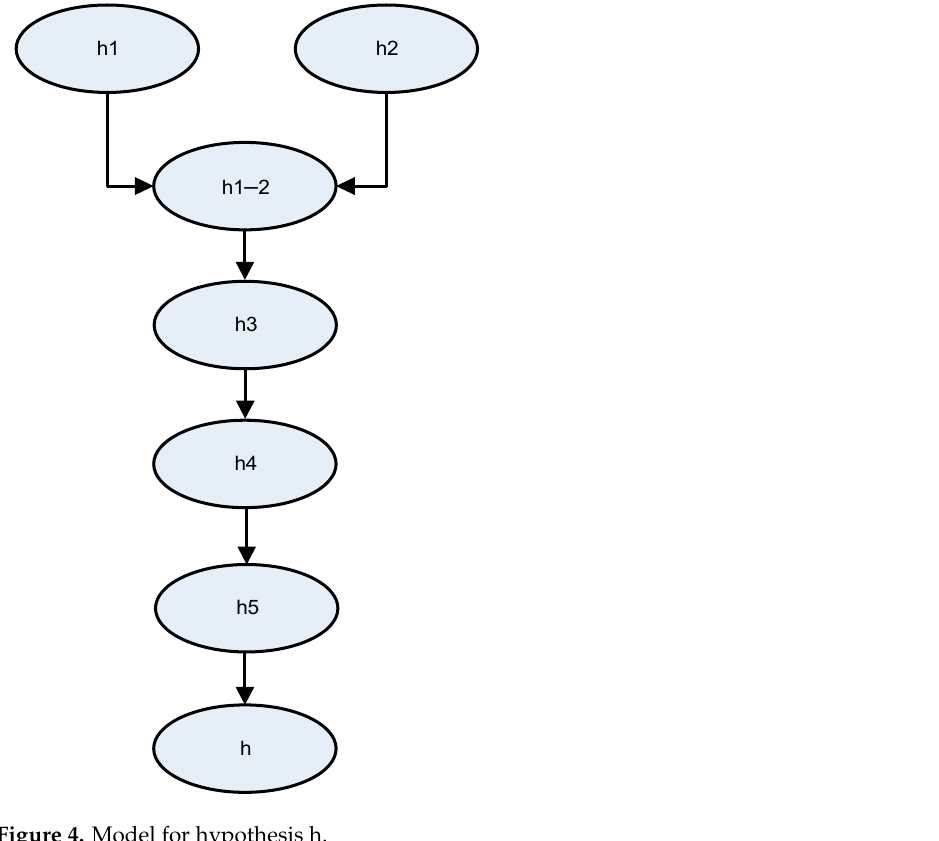
Figure 4. Model for hypothesis h.